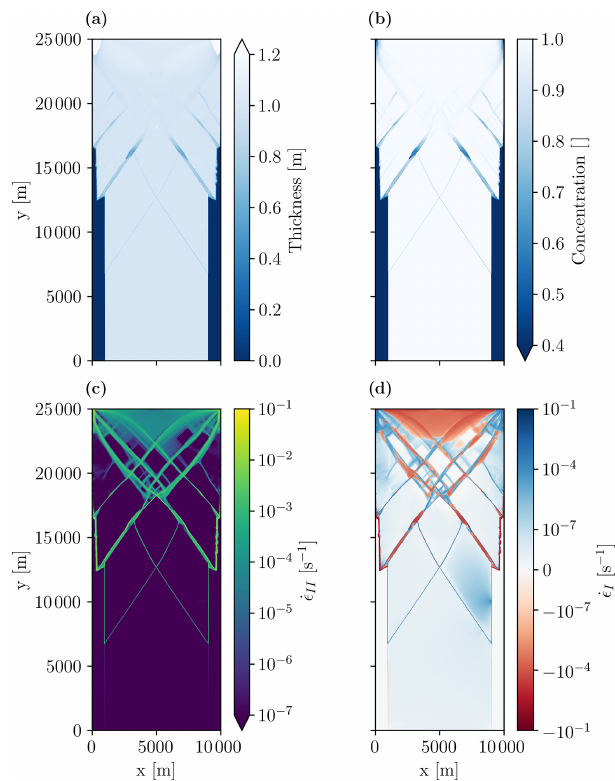
Figure 6. Sea ice thickness (a) , concentration (b) , maximum shear strain rate (c) , and divergence (d) after 45min of integration (2700s) in a uni-axial loading test. To make these longer simula- tions possible, both nonlinear and linear iterations are limited to 150 per time step. Results show the development of secondary fracture lines in all fields after the first fracture line has